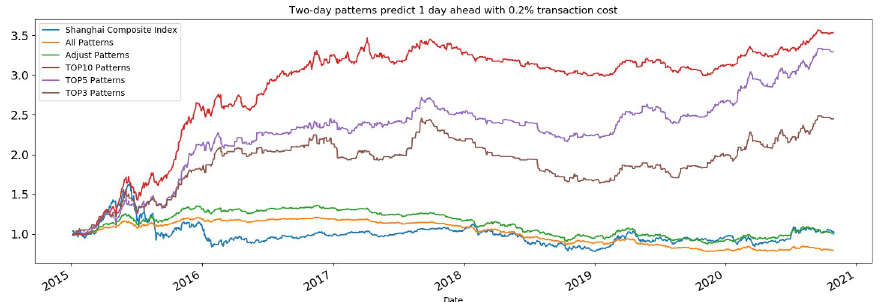
Fig 11. Portfolio return of two-day predictions one day ahead with 0.2% transaction